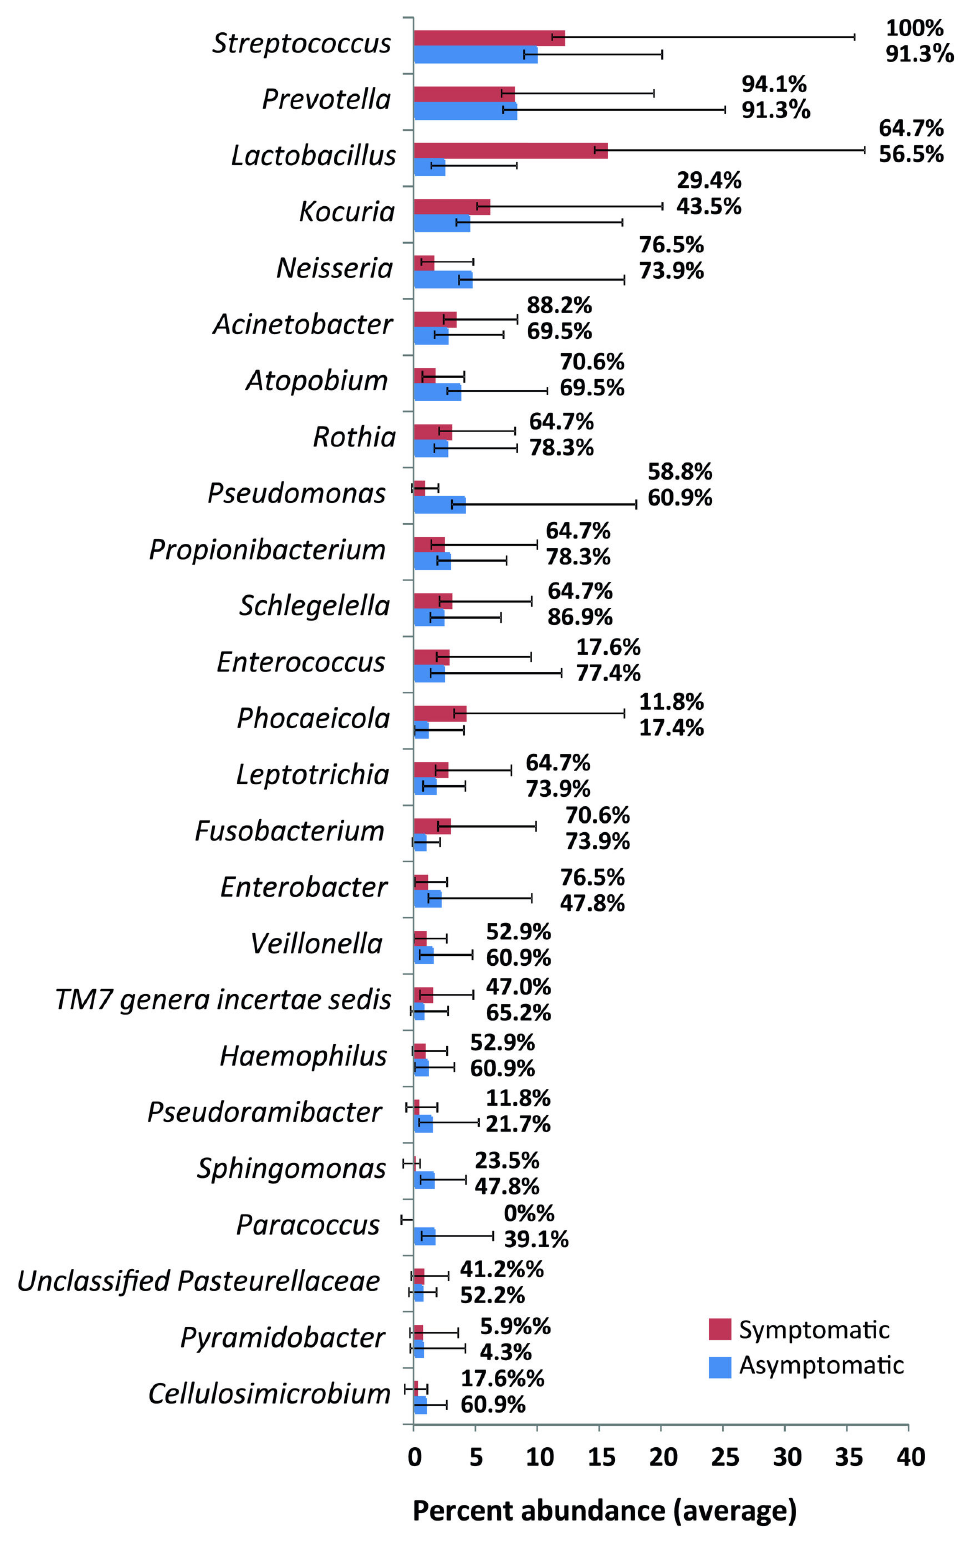
Figure 3. Summarizes the distribution of the top 25 most abundant genera in symptomatic (red) and asymptomatic cases (blue) with their relative abundance data (depicted as bars) and prevalence values (given as numbers next to bars).